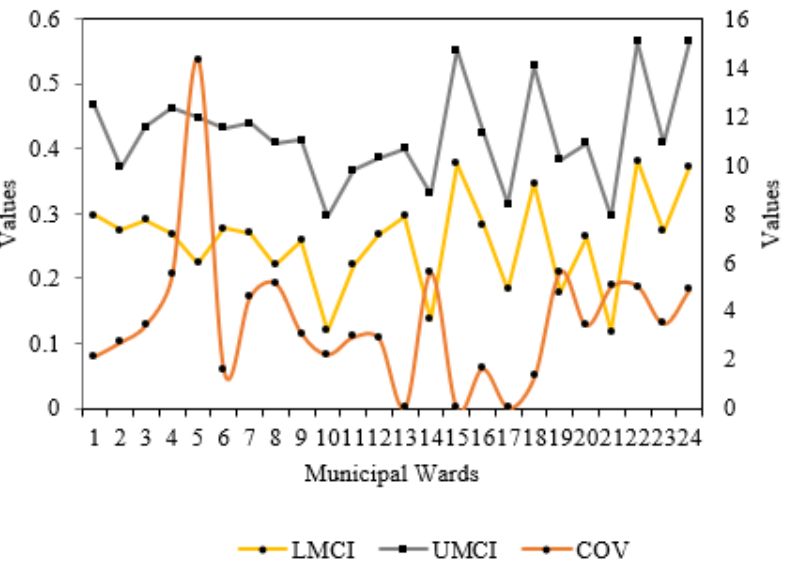
Figure 54. Plotted graph of Lower Mean Confidence Interval (LMCI), Upper Mean Confidence Figure 54. Plo tt ed graph of Lower Mean Con fi dence Interval (LMCI), Upper Mean Con fi dence Interval (UMCI), and Covariance (COV) of regression analysis. Interval (UMCI), and Covariance (COV) of regression